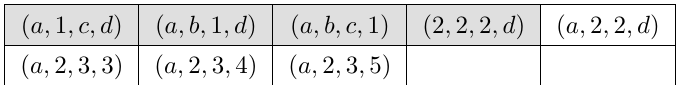
Table 18 . Infinite sequences of type XIV singularities. The gray entries are either reducible to previous types or have at least one of b, c, d = 1 , which gives trivial 1-form symmetry. This table is adapted from